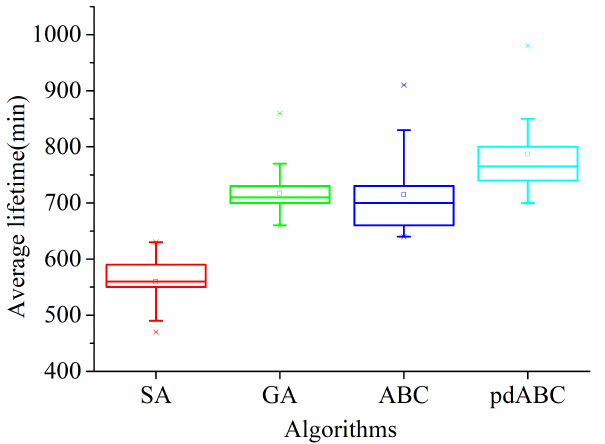
Figure 12. Optimal lifetime distribution box plot with twenty-two RNs in 200 × 200